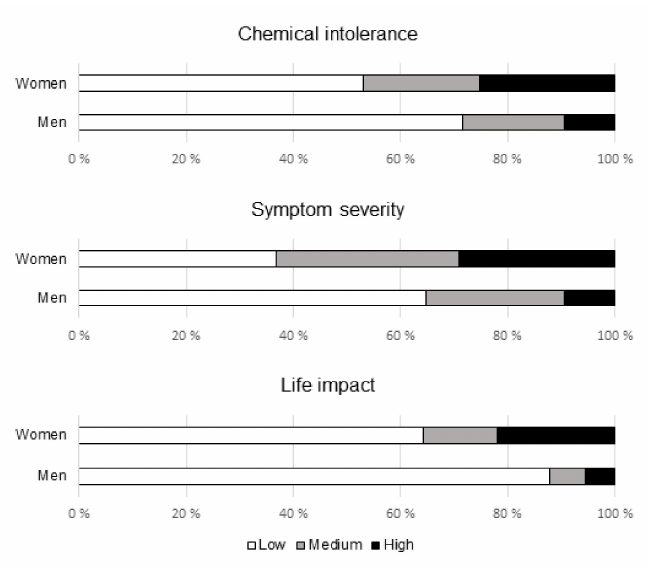
Figure 2. Proportions of controls with low, medium, and high scores in chemical intolerance ( p = 0.004), symptom severity ( p < 0.001), and life impact ( p < 0.001) among women and men (X 2 testing with 3 × 2